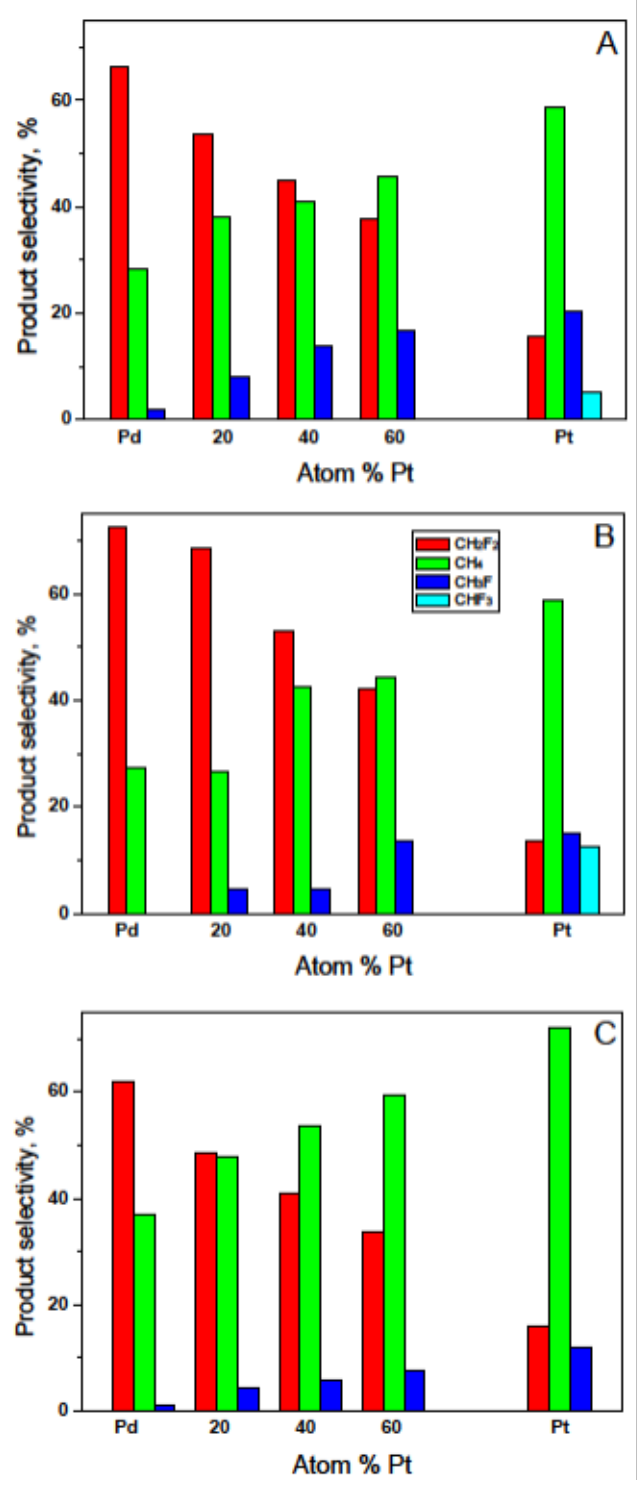
Figure 8. Product selectivity as a function of the Pd–Pt alloy composition for the ex-acac series ( A , B ) after additional calcination at 300 °C and the ex-chloride series ( C ). Reaction temperature 272 °C. GHSV = 5760 h −1 .